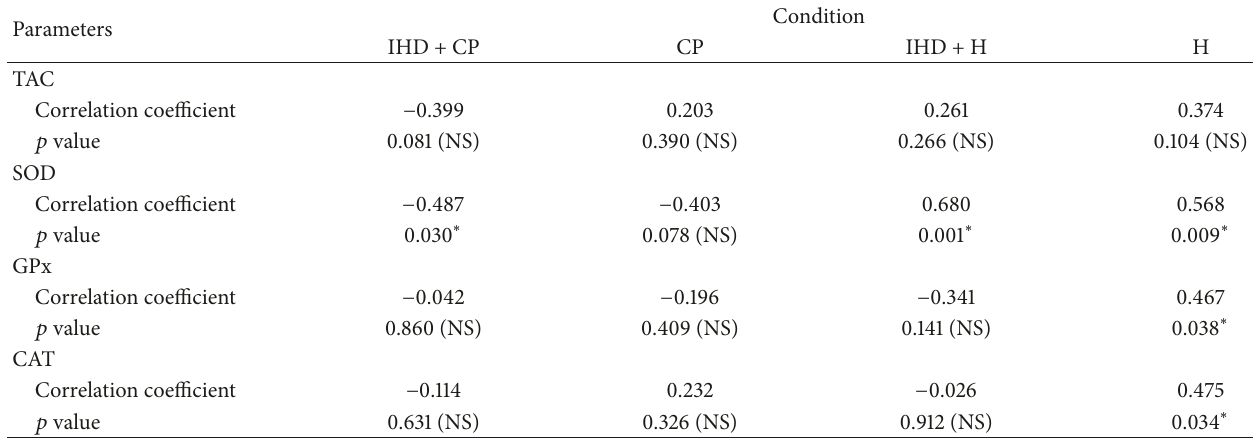
Table 5: Correlation between serum and salivary levels of TAC, SOD, GPx, and